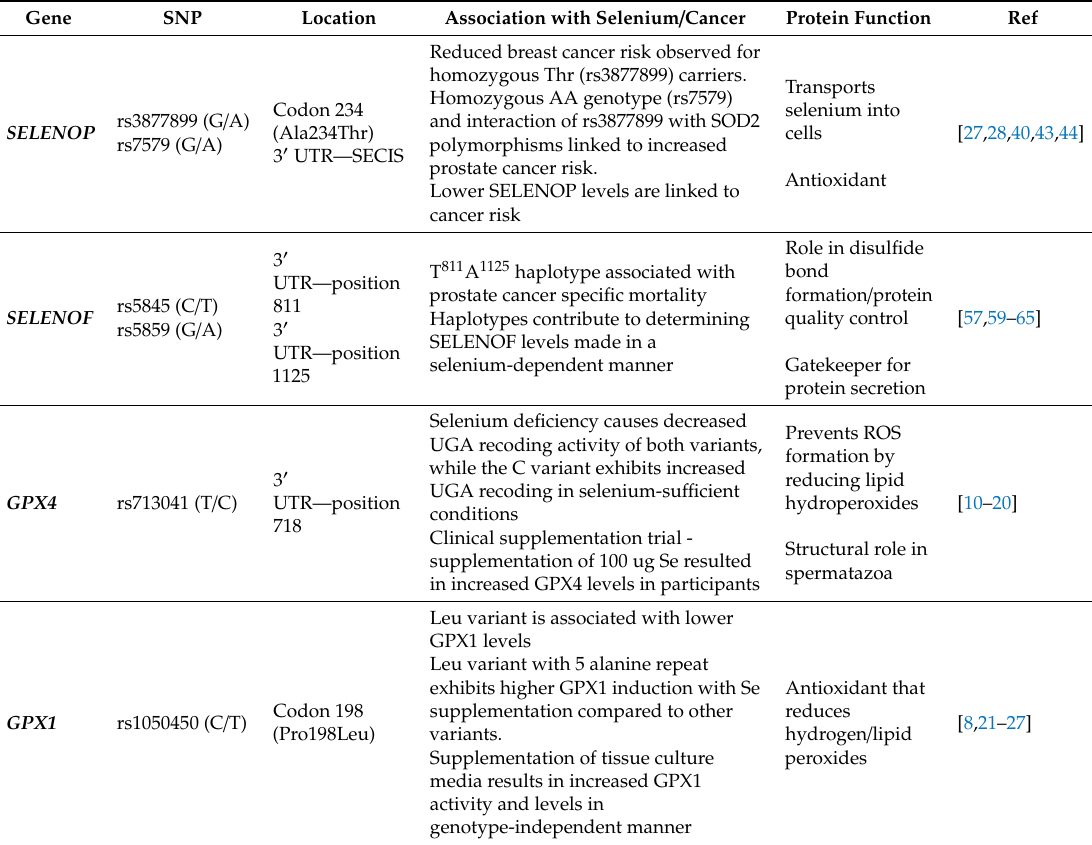
Table 1. Polymorphisms in selenoprotein genes associated with cancer risk or mortality as well as regulation by selenium